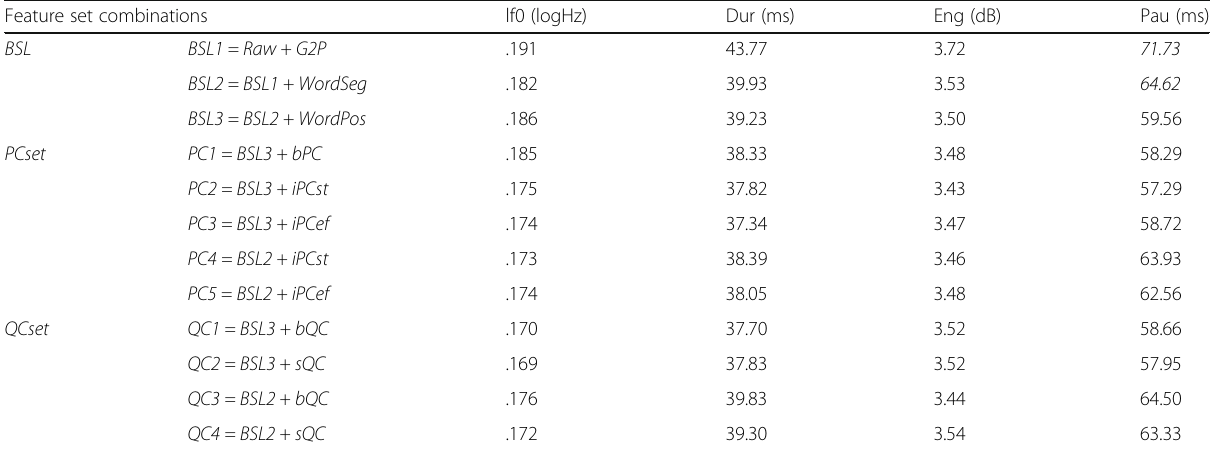
Table 15 RMSEs for the four prosodic – acoustic features Feature set combinations